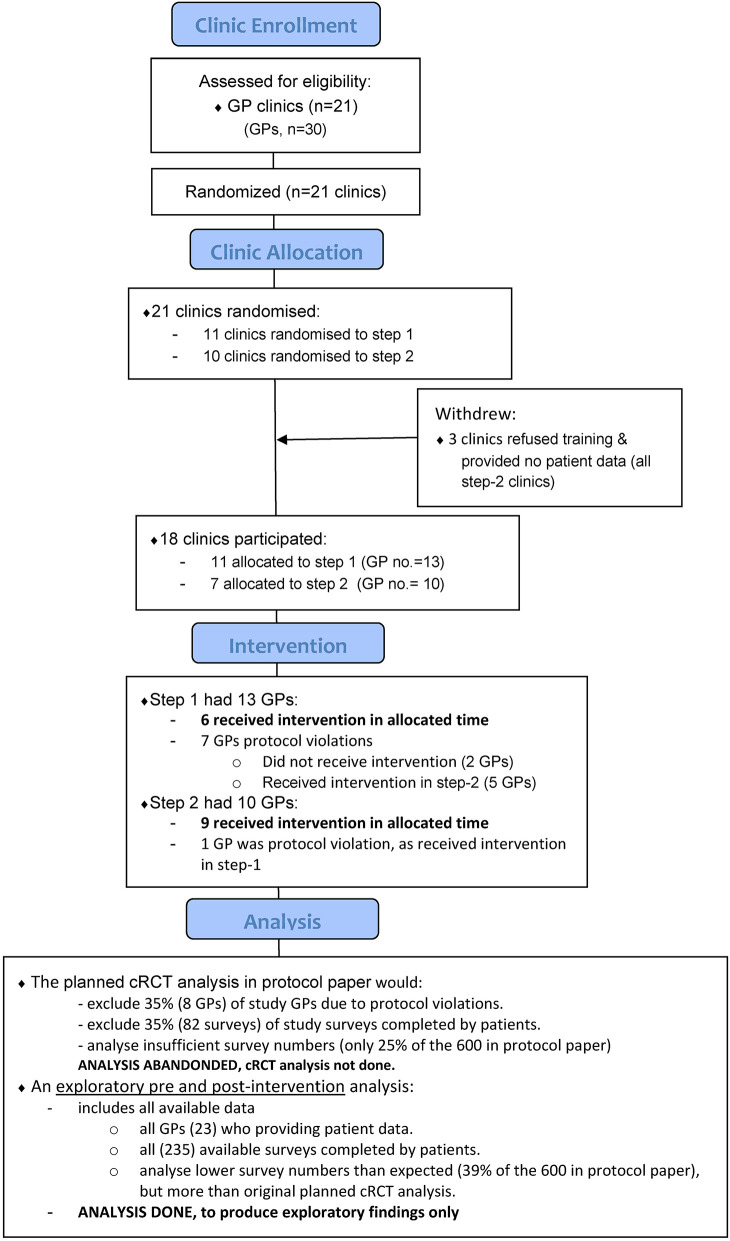
Participating clinic and general practitioner (GP) flow diagram. GPs allocated to step 1 were planned to undergo training first, and then approximately 9 months later, the step 2 GPs trained. However, protocol violations occurred and sometimes GPs in either group trained together. Together with Supplementary File 1, it shows the original stepped-wedge cRCT intervention design was not achieved. Instead, exploratory pre and post-intervention analyses were done.